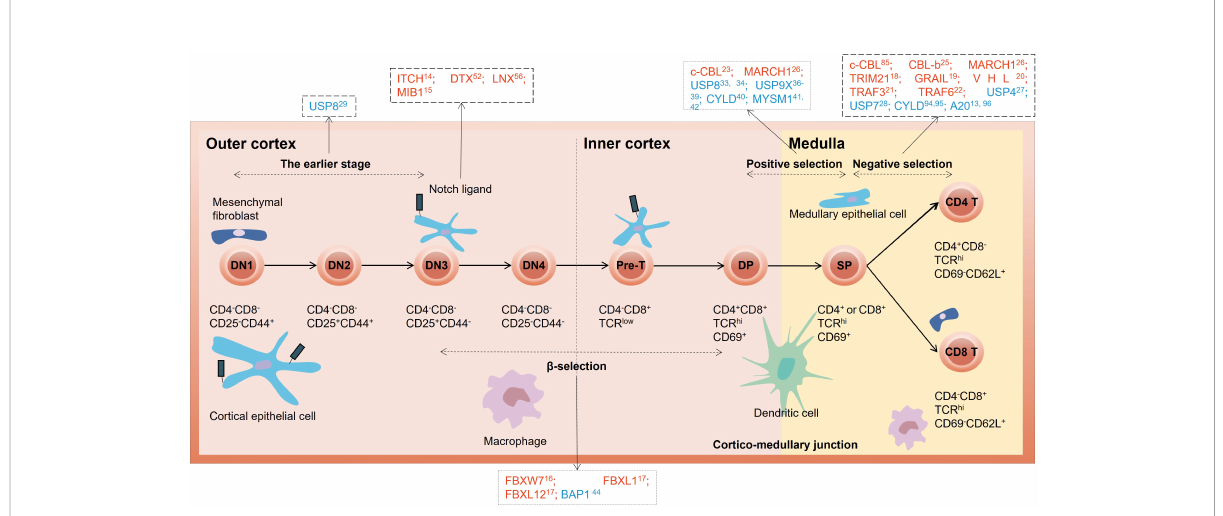
FIGURE 1 Overview of E3 ubiquitin ligases and DUBs in different stages of thymocyte development. The red letters in the black dotted box represent E3 ubiquitin ligases, and the blue letters represent DUBs. DN, double-negative; DP, double-positive; SP,